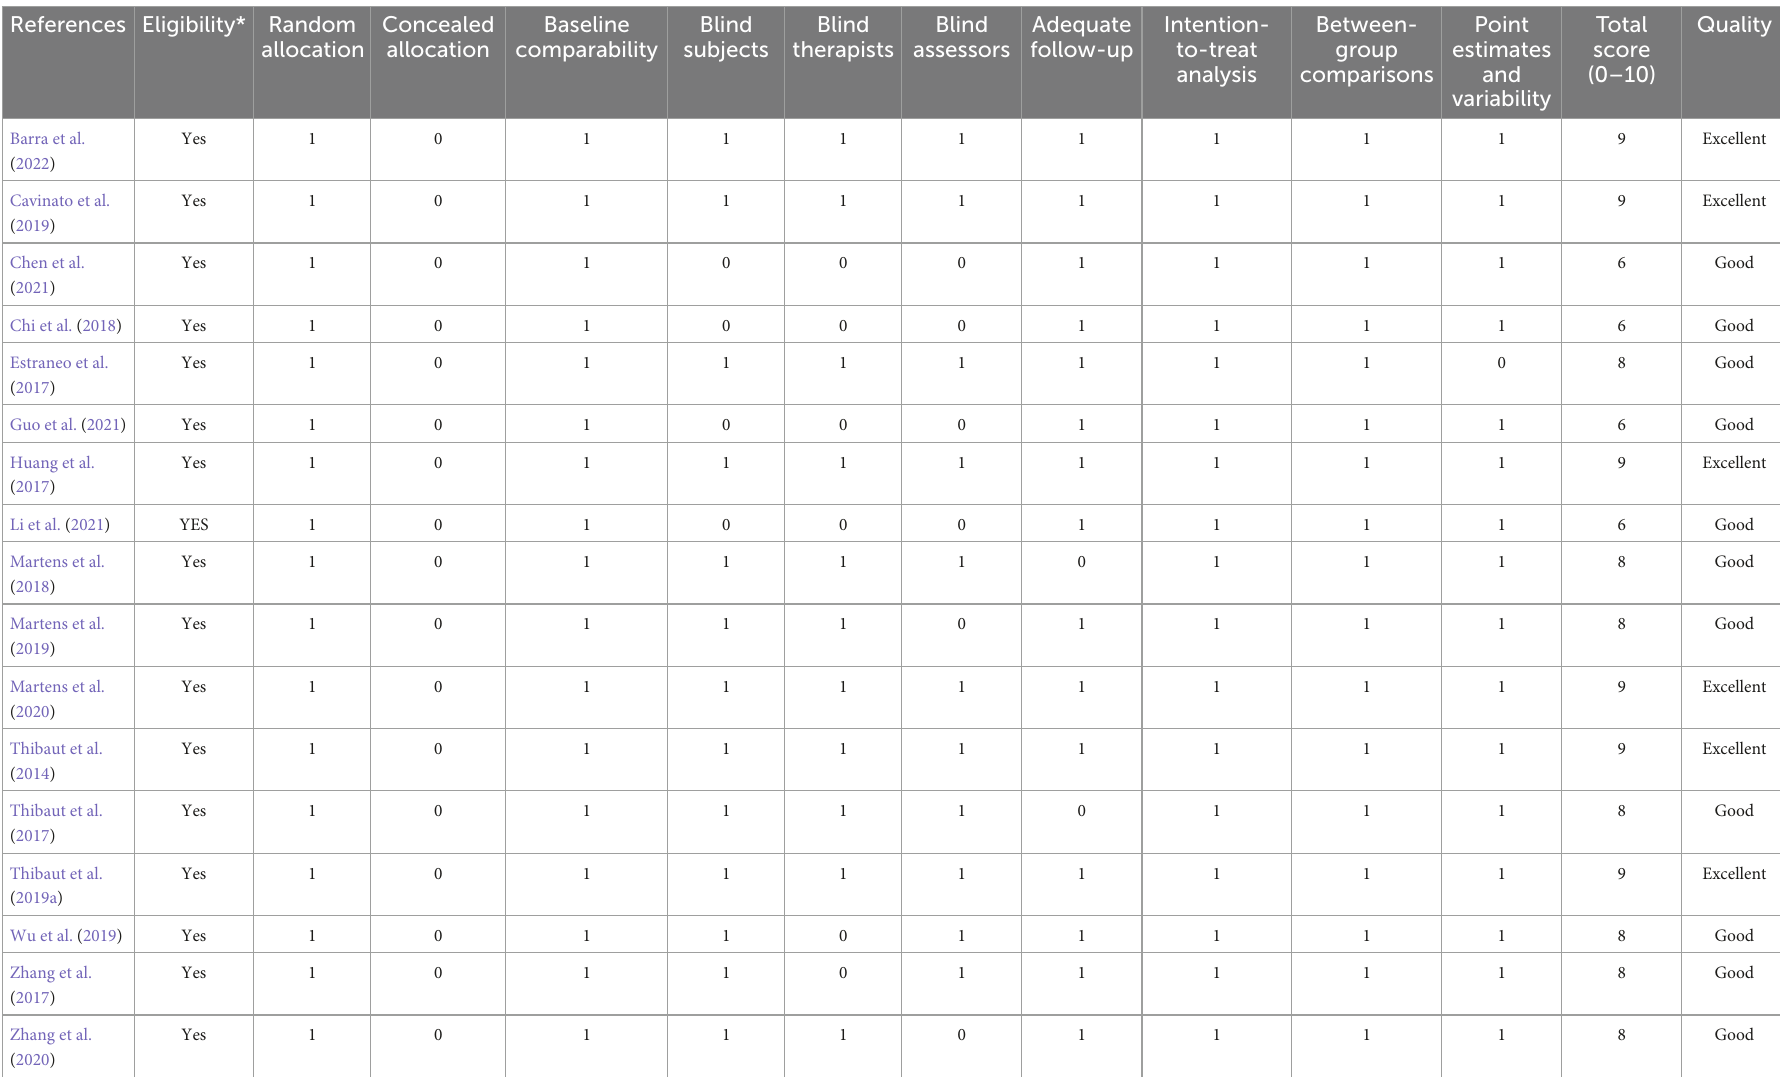
TABLE 2 PEDro assessment quality results of included